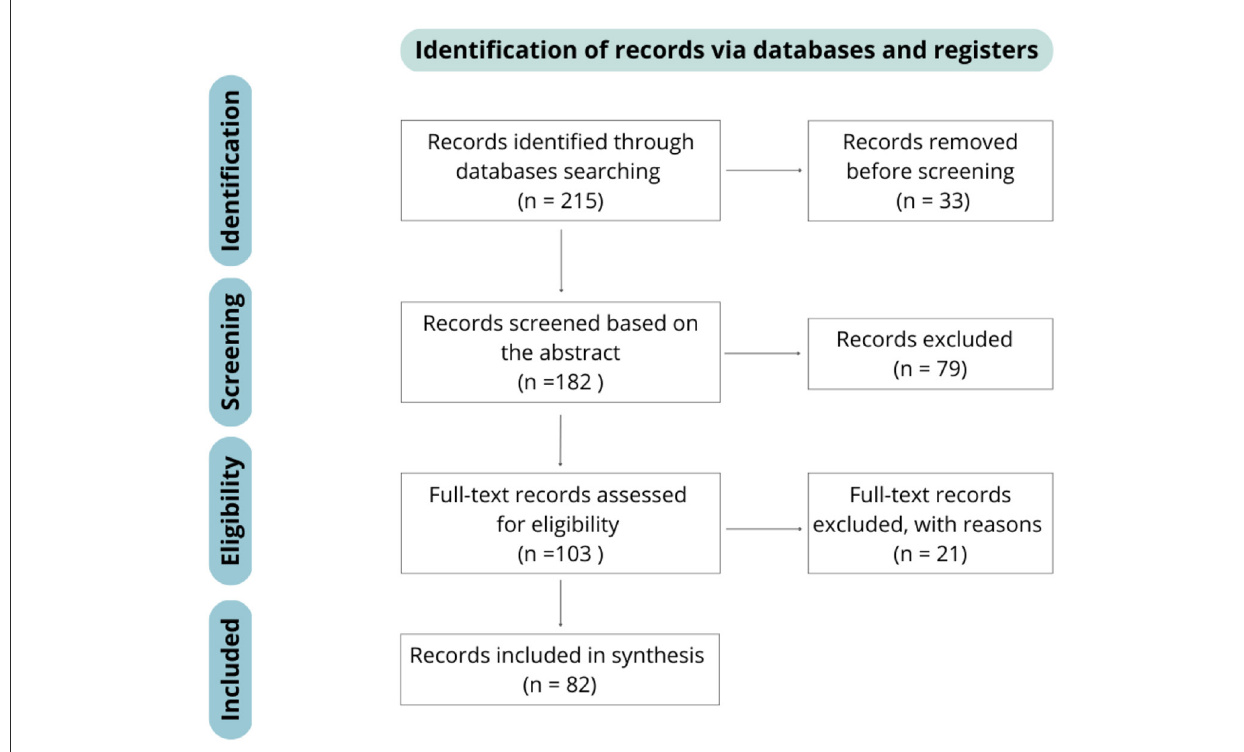
FIGURE1 PRISMA flow